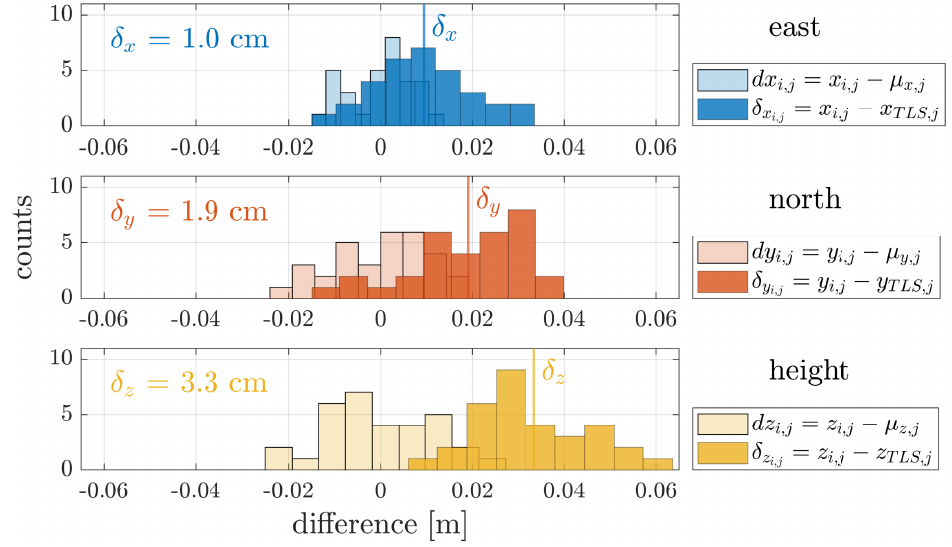
Figure 8. Histogram for East, North and height difference of estimated target coordinates for four flights. Results are separated in estimates for the precision and absolute accuracy compared to the TLS